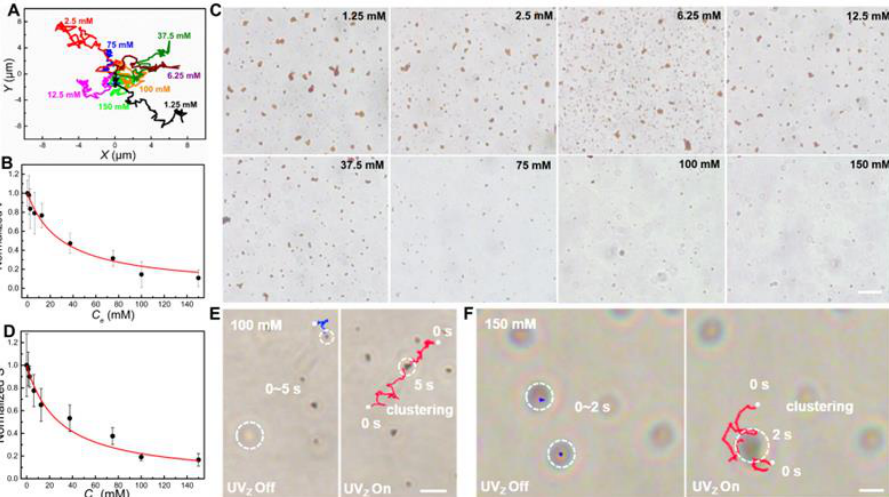
Figure 4. Ion tolerance of the Fe 2 O 3 TNMs. ( A ) Trajectories of the light-driven Fe 2 O 3 TNMs at different C e . ( B ) The normalized speed v of the nanomotors versus C e . ( C ) Microscopic images describing the clusters of the Fe 2 O 3 TNMs after irradiated by UV Z irradiation for 30 s. The scale bar is 10 μm. The I of the applied UV Z light in these experiments is 513 mW/cm 2 . ( D ) The normalized S of the nanomotor clusters versus C e . ( E , F ) Microscopic images showing light-activation and clustering of the Fe 2 O 3 TNMs stuck on the substrate at C e of 100 ( E ) and 150 mM ( F ), respectively. Scale bars in ( E , F ) are 4 μm, 2 μm.